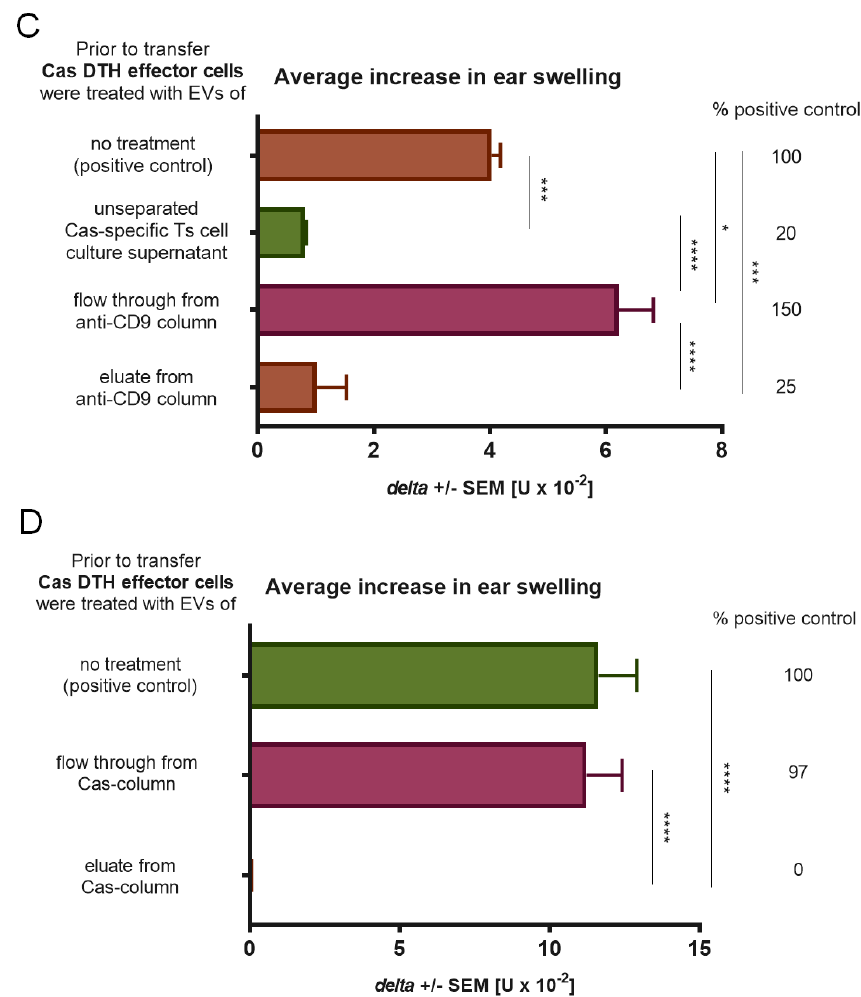
Figure 3. Suppression of delayed-type hypersensitivity (DTH) to soluble casein (Cas) antigen is mediated by CD8 + suppressor T (Ts) cell-derived extracellular vesicles (EVs) expressing CD9 and CD81 tetraspanins and Cas-specific antibody light chains. ( A ) Mice had been intravenously administered with Cas-coupled syngeneic red blood cells, followed by intradermal (id) immunization with a saline solution of soluble Cas antigen (100 µ g per mouse) 3 days before harvest of lymph nodes and spleens containing Ts cells, which were then subjected to positive selection assay, i.e., magnetic-advanced cell sorting, and cultured for subsequent 48 h. The resulting supernatant was filtered and ultracentrifuged to concentrate Ts cell EVs, used to treat DTH e ff ector cells prior to adoptive transfer to recipients, challenged 24 h later by id administration of the same Cas solution (5 µ g per earlobe). After 24 h, ear swelling response was measured and expressed as delta ± SEM [units (U) × 10 − 2 mm] (n = 5, N = 2). ( B ) Ts cell EVs were coated onto latex beads, stained with monoclonal antibodies against CD9, CD63, and CD81 tetraspanins or against mouse antibody kappa light chains, and then analyzed by flow cytometry (n = 3, N = 2). ( C ) Ts cell EVs were separated by antigen a ffi nity chromatography on column filled with Sepharose coated with anti-CD9 monoclonal antibodies, and the resulting fractions, i.e., flow through or eluate, were used to treat DTH e ff ector cells prior to adoptive transfer to recipients, challenged 24 h later by id administration of the same Cas solution (5 µ g per earlobe). After 24 h, ear swelling response was measured and expressed as delta ± SEM [units (U) × 10 − 2 mm] (n = 5, N = 2). ( D ) Ts cell EVs were separated by antigen a ffi nity chromatography on column filled with Cas-coated Sepharose, and the resulting fractions, i.e., flow through or eluate, were used to treat DTH e ff ector cells prior to adoptive transfer to recipients, challenged 24 h later by id administration of the same Cas solution (5 µ g per earlobe). After 24 h, ear swelling response was measured and expressed as delta ± SEM [units (U) × 10 − 2 mm] (n = 5, N = 3). * p < 0.05; ** p < 0.01; *** p < 0.001; **** p <